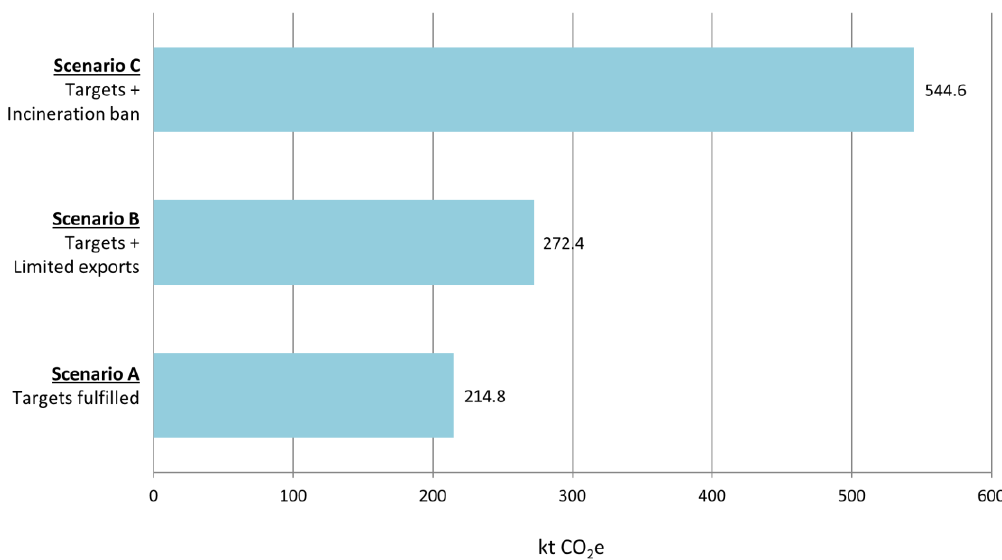
Figure 1. Greenhouse gas (GHG) savings of increased plastic recycling in Sweden.